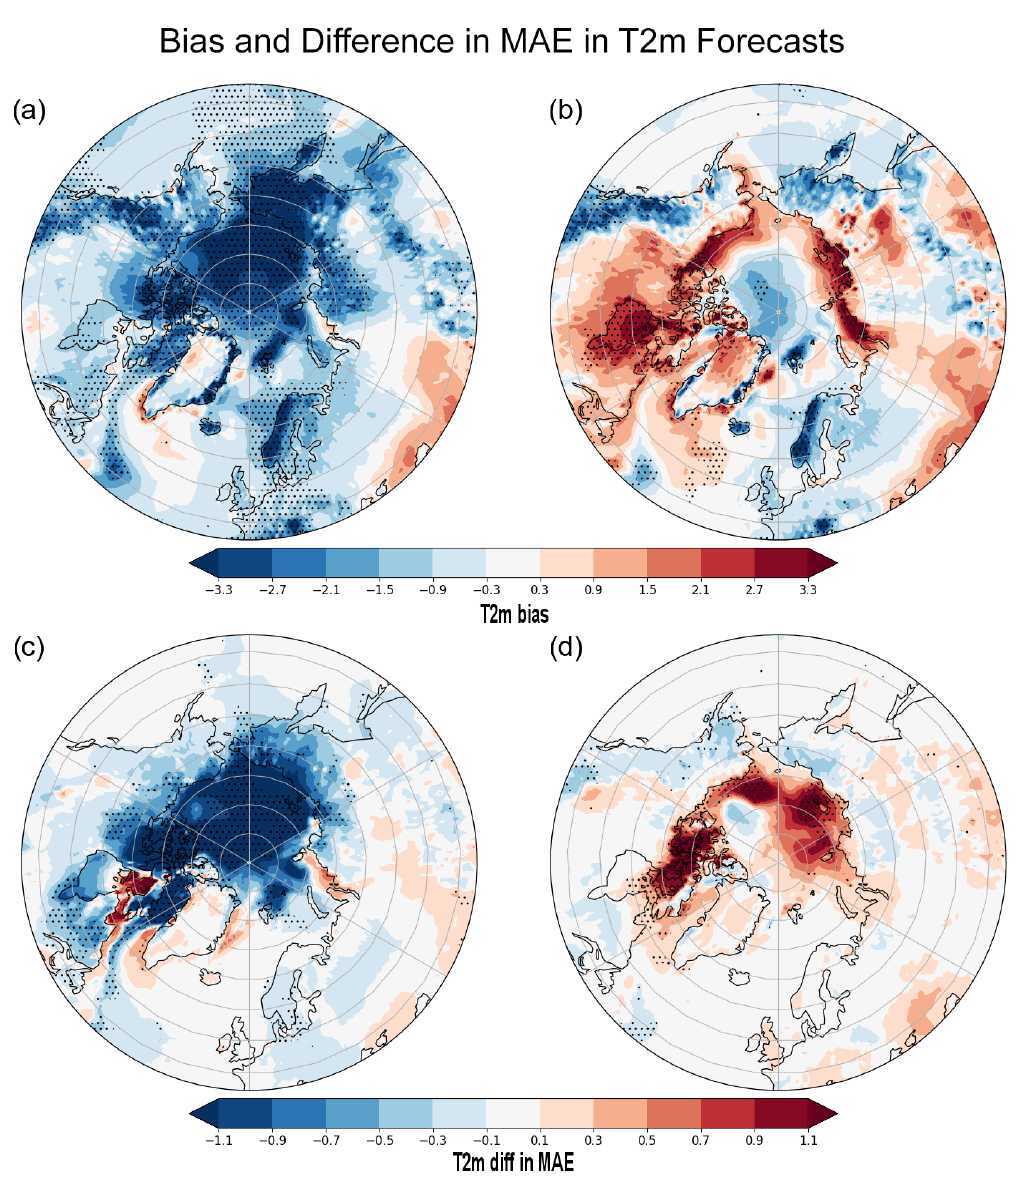
Figure 12. Bias and difference in MAE of 2m temperature against ERA5 for SON forecasts started in May (a, c) and August (b, d) respectively: bias (in K) of FC-REF is shown on the top (a, b) and MAE difference (in K) between FC-SIT and FC-REF at the bottom (c, d) . Differences significant at the 5% level according to the sign test as recommended by DelSole and Tippett (2016) are stippled. The homogeneous warming of FC-SIT with respect to FC-REF shown in Fig. 11c results in MAE for SON T2m being reduced for May start dates (c) and increased for August start dates (d)